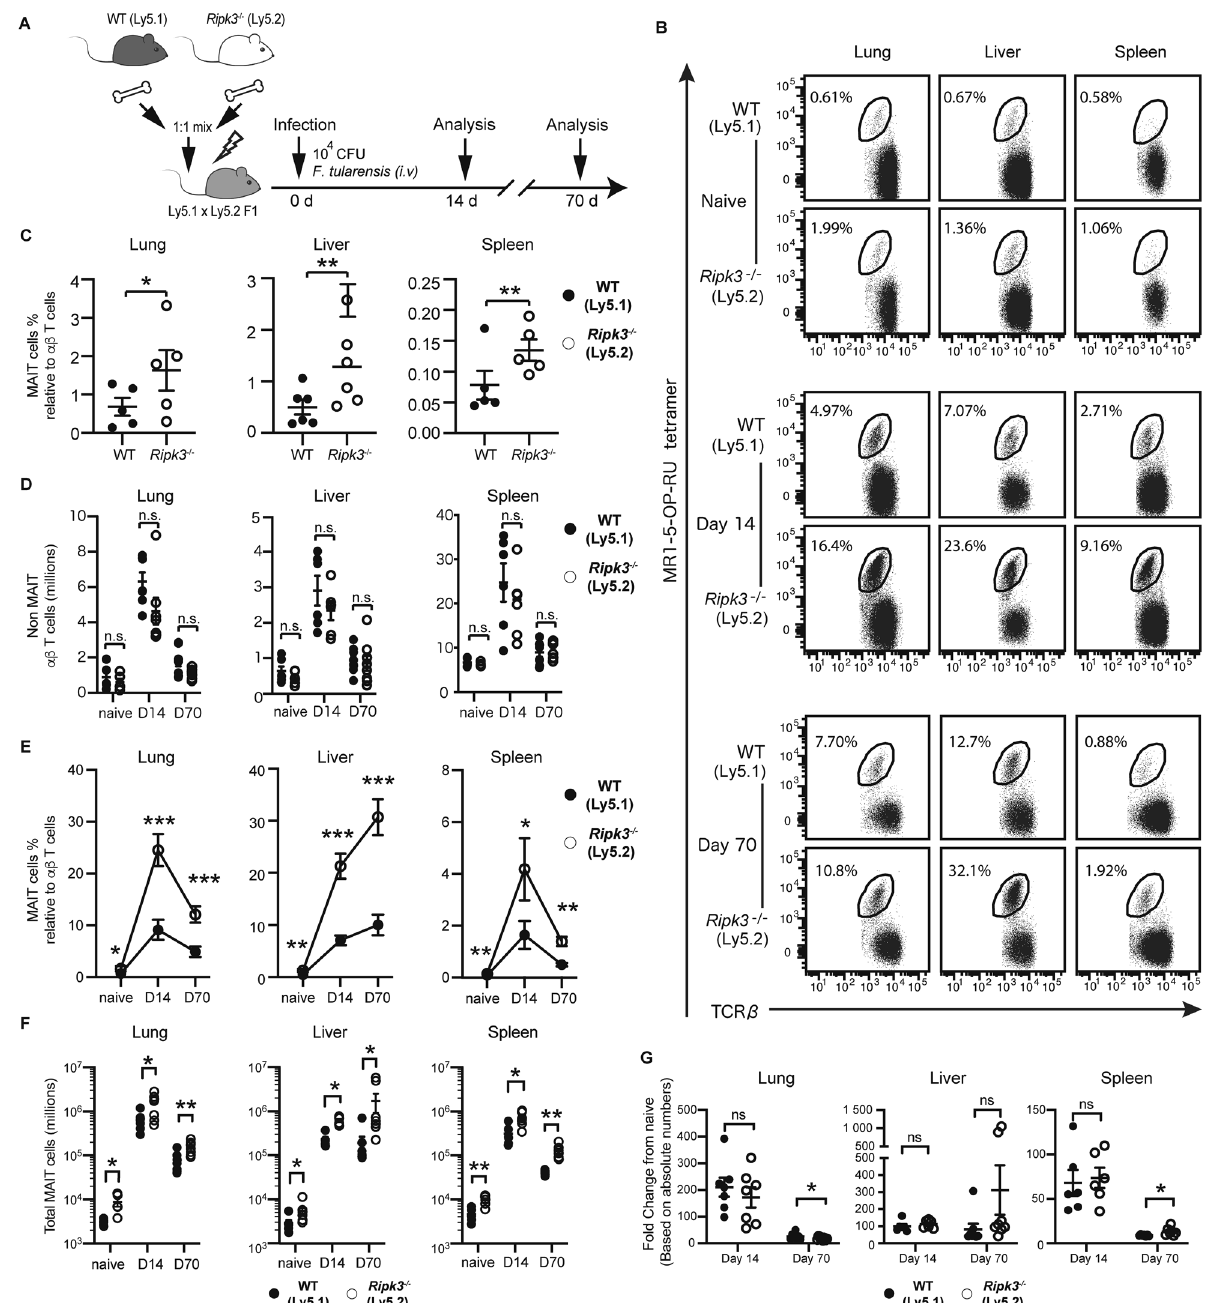
Fig. 5 Ripk3 − / − MAIT cells are speci fi cally expanded in mixed chimera mice at baseline and through infection. WT: Ripk3 − / − mixed bone marrow chimeric mice were generated by co-transfer of WT (Ly5.1) and Ripk3 − / − (Ly5.2) bone marrow, and then either uninfected or infected with 10 2 CFU of F. tularensis LVS (i.t.) for 14 or 70 days, as indicated. A Schematic showing the experimental design. B Flow plots showing TCR β + lymphocytes with WT (Ly5.1) and Ripk3 − / − (Ly5.2) MAIT cells gated in naïve mice and at the indicated time points postinfection. MAIT cell abundance is expressed as a percentage relative to non-MAIT TCR β + lymphocytes. C Relative MAIT cell abundance (as in B ) in uninfected mice showing WT (Ly5.1) and Ripk3 − / − (Ly5.2) from the same recipient mice. D Absolute numbers of MAIT cells and non-MAIT TCR β + T cells in naïve and infected mice. E Relative abundance of WT and Ripk3 − / − MAIT cells within chimeric mice, expressed as the percentage of TCR β + lymphocytes at indicated time points postinfection. F Absolute numbers of WTand RIPK3 − / − MAIT cells within chimeric mice, at indicated time points postinfection. G WT and Ripk3 − / − MAIT cells within chimeric mice expressed as fold change at day 14 and day 70 postinfection relative to uninfected mice. C-G Symbols show the mean ± SEM of data pooled from 2 independent experiments (naïve n = 5; d14 n = 7; and d70 n = 8). Statistical signi fi cance is indicated by ns ( p >0.05); * ( p ≤ 0.05); * * ( p ≤ 0.01); or *** ( p ≤ 0.001) as determined by a paired two-tailed t- noncanonical apoptotic and necroptotic functions in cardiac tissue and egress. One such alternate pathway is the Calcium/ [41, 42], while also regulating several non-death functions in Calmodulin-dependent kinase II (CaMKII) cell death pathway, T cells [43, 44] and promoting survival of double positive (DP) which can be activated by RIPK3 activity [39 – 41]. The CamKII thymocytes during development [44]. pathway is well-reviewed for its pleiotropic role in regulating both